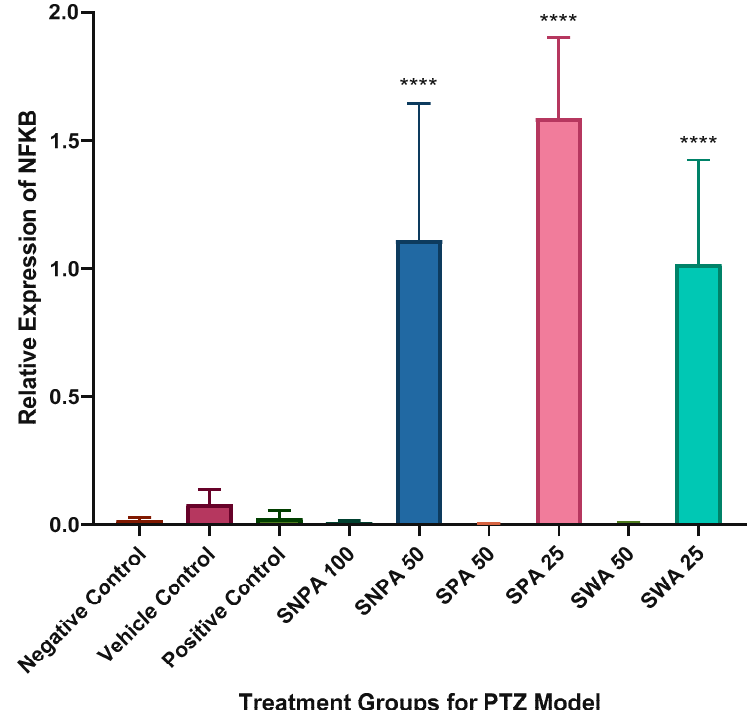
Figure 6. Graphical representation of the relative expression of NF- κ B in each treatment group ( n = 6). The data were expressed as mean ± SEM using one-way ANOVA (**** p < 0.0001).